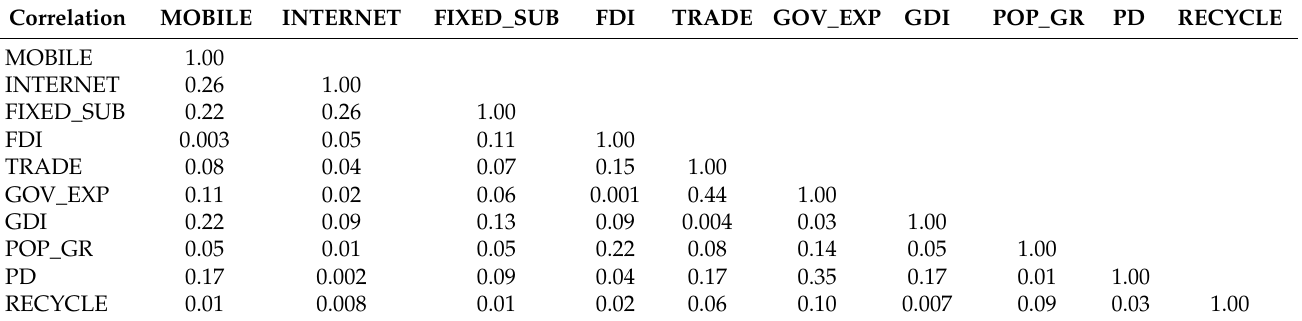
Table 4. Correlation matrix between the independent variables and control variables.